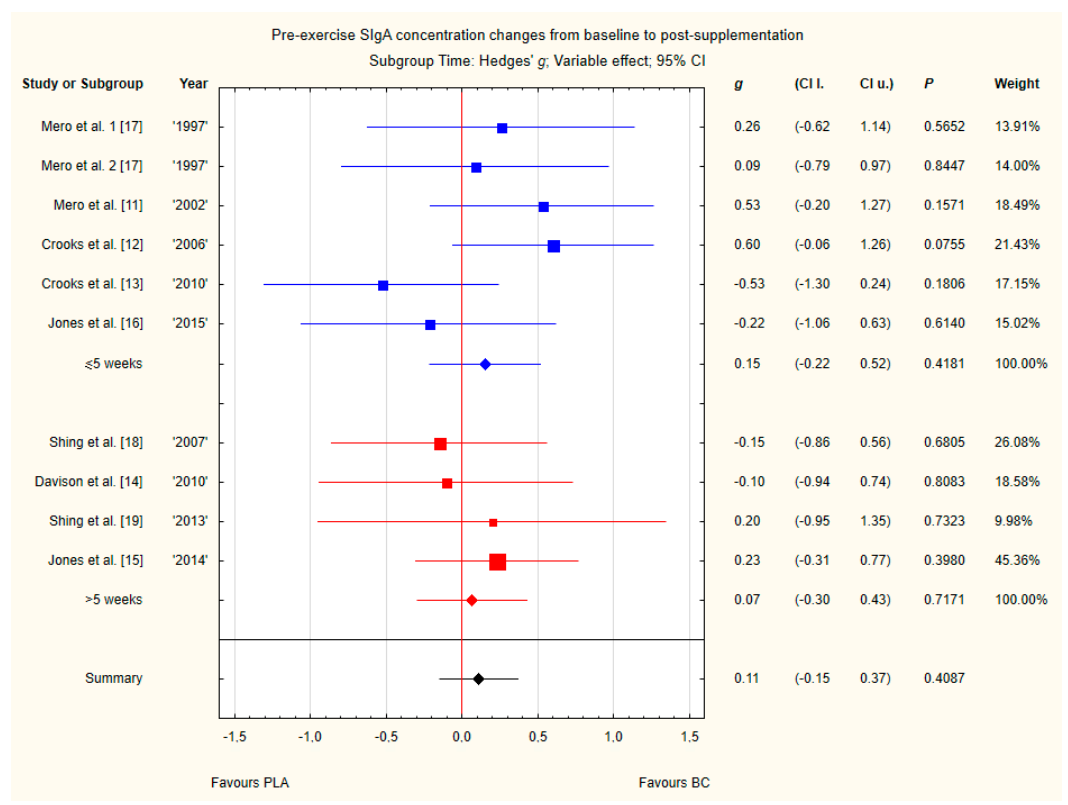
Figure 13. Forest plot of the random-effects meta-analysis of changes from baseline to post-supplementation in pre-exercise SIgA concentration in subgroups regarding BC supplementation time. Test for subgroup differences: Chi 2 = 0.1; df = 1; P = 0.75. 1–the first dose from Mero et al. [17]